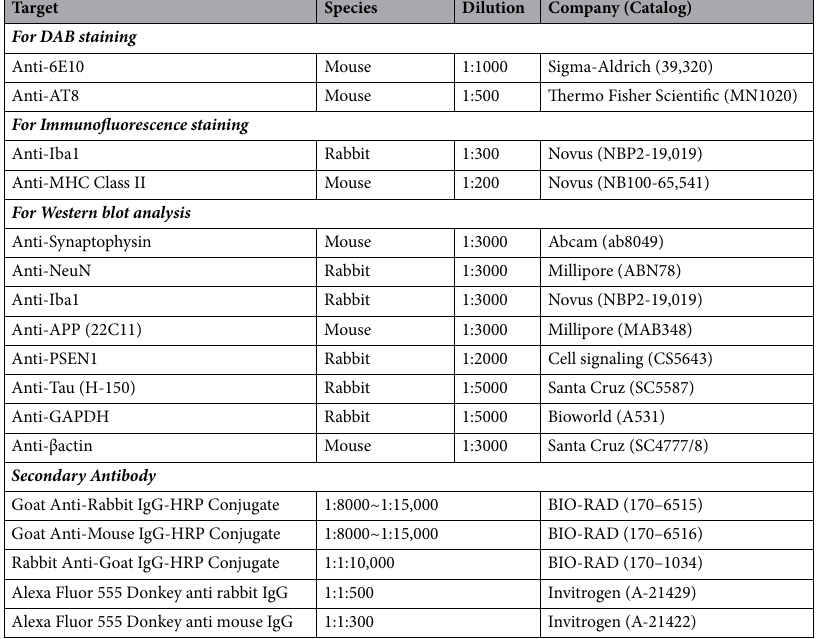
Table. 1.. List of antibodies used in this